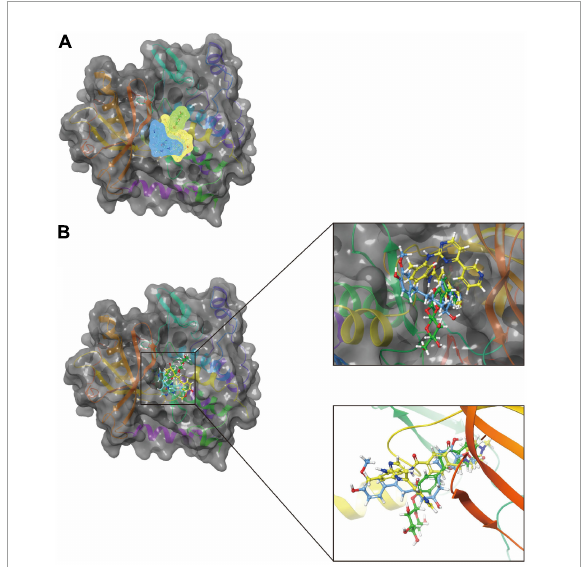
FIGURE5 A comparison of the spatial conformation of small molecules in protein binding pockets with the gray surface of platelet-derived growth factor receptor α (PDGFRA). (A) In yellow, green, and red, respectively, are the structures and net electron cloud structures of ZINC000008829785, ZINC000013377891, and Imatinib. (B) Structures of ZINC000008829785, ZINC000013377891, and Imatinib are shown in yellow, green, and red sticks, respectively.